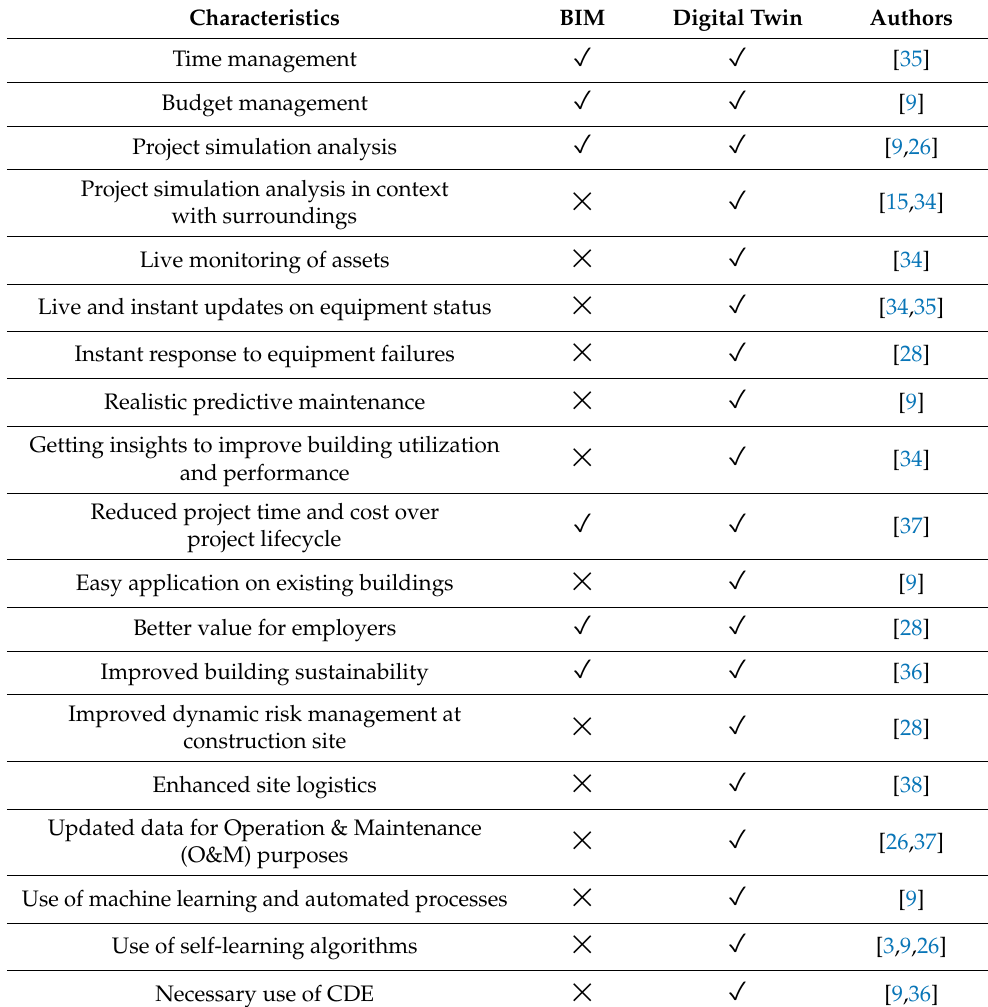
Table 3. Characteristics of BIM and digital twin as reported by different studies.